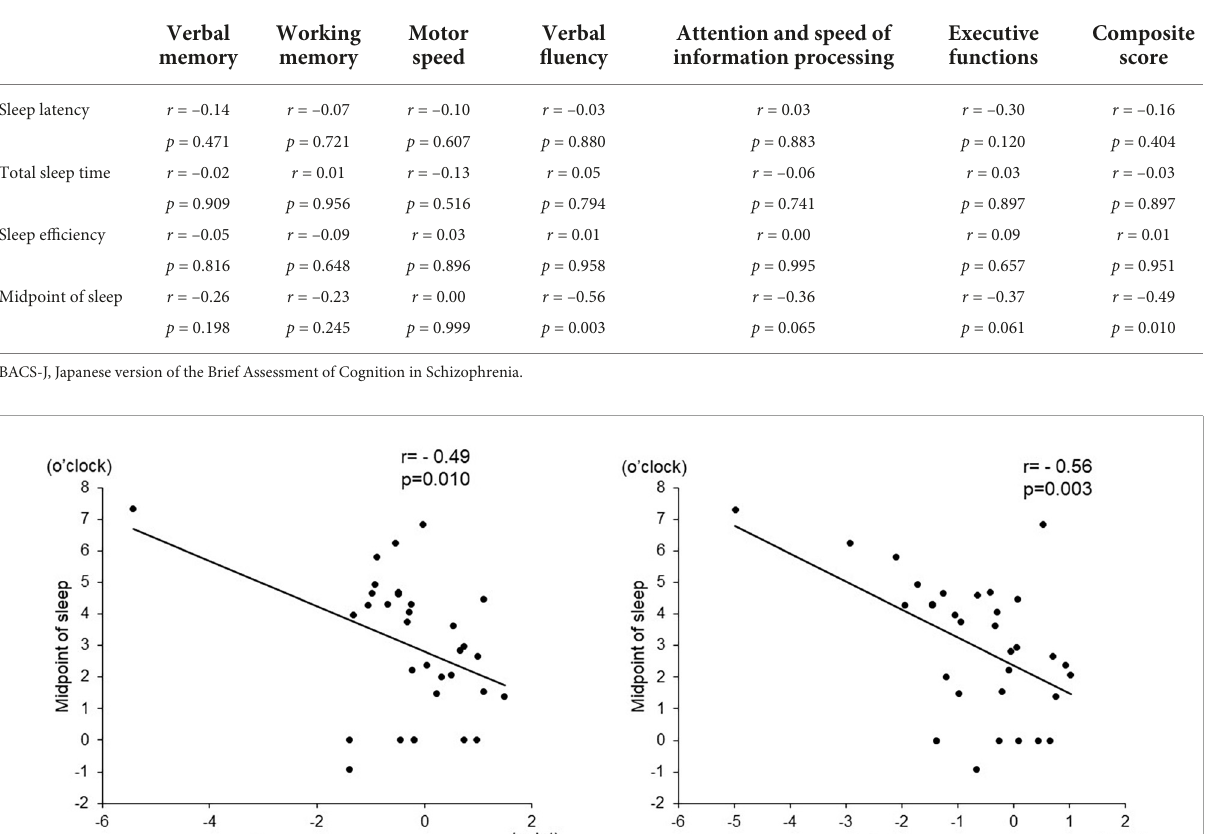
TABLE 2 Correlation between sleep parameters and BACS-J scores.